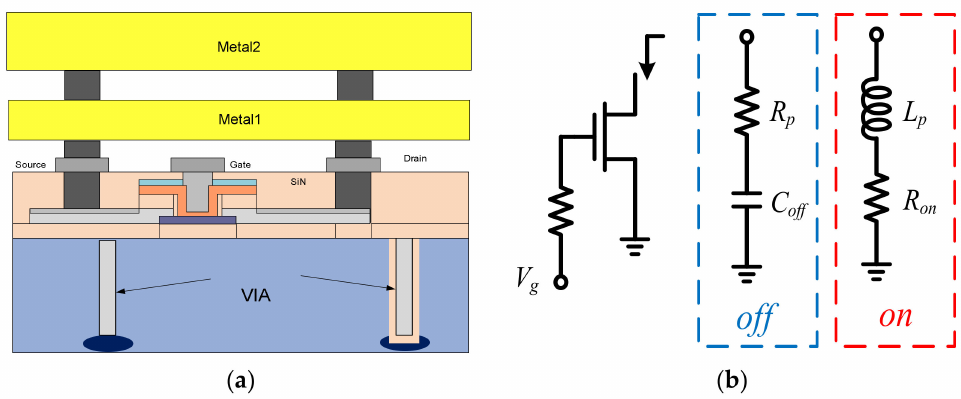
Figure 2. ( a ) The cross-section of the GaAs process; ( b ) the model of the transistor in different